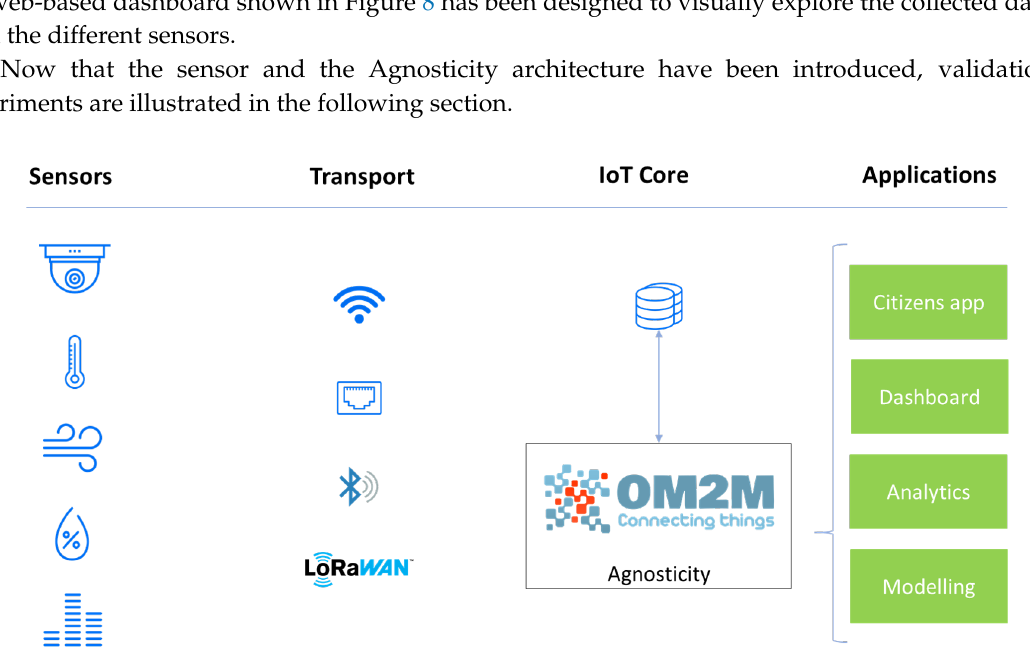
Figure 7. The general architecture of the project. The Agnosticity software stack relies on well established open-source software. The data collection and access is ensured by the open-source implementation of the OM2M